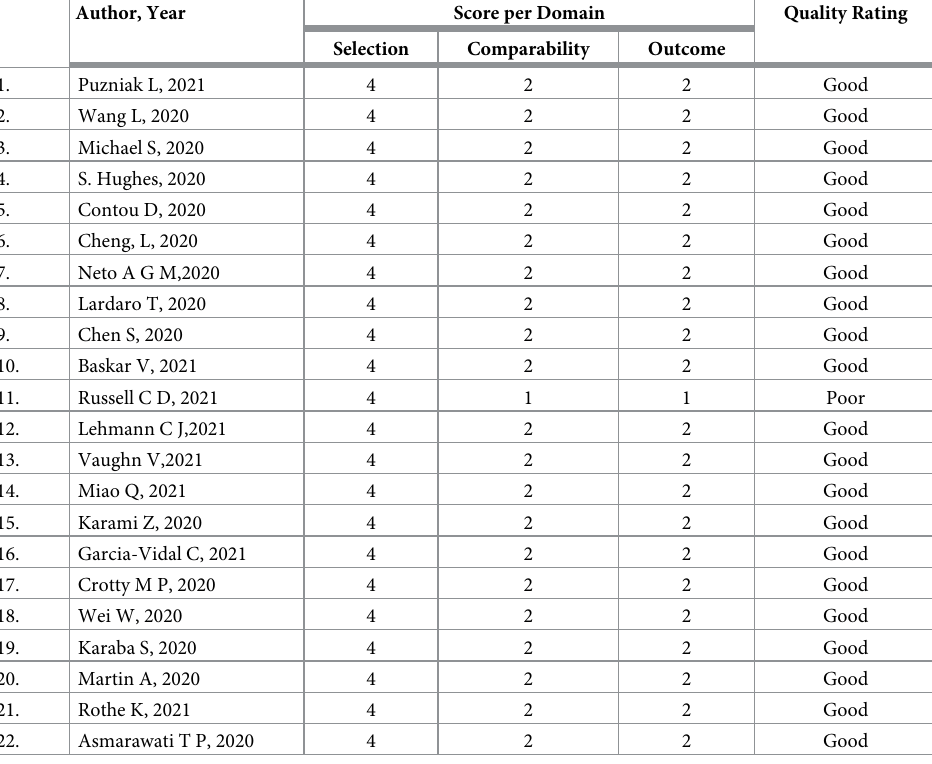
Table 2. Risk of bias assessment using Newcastle-Ottawa scale